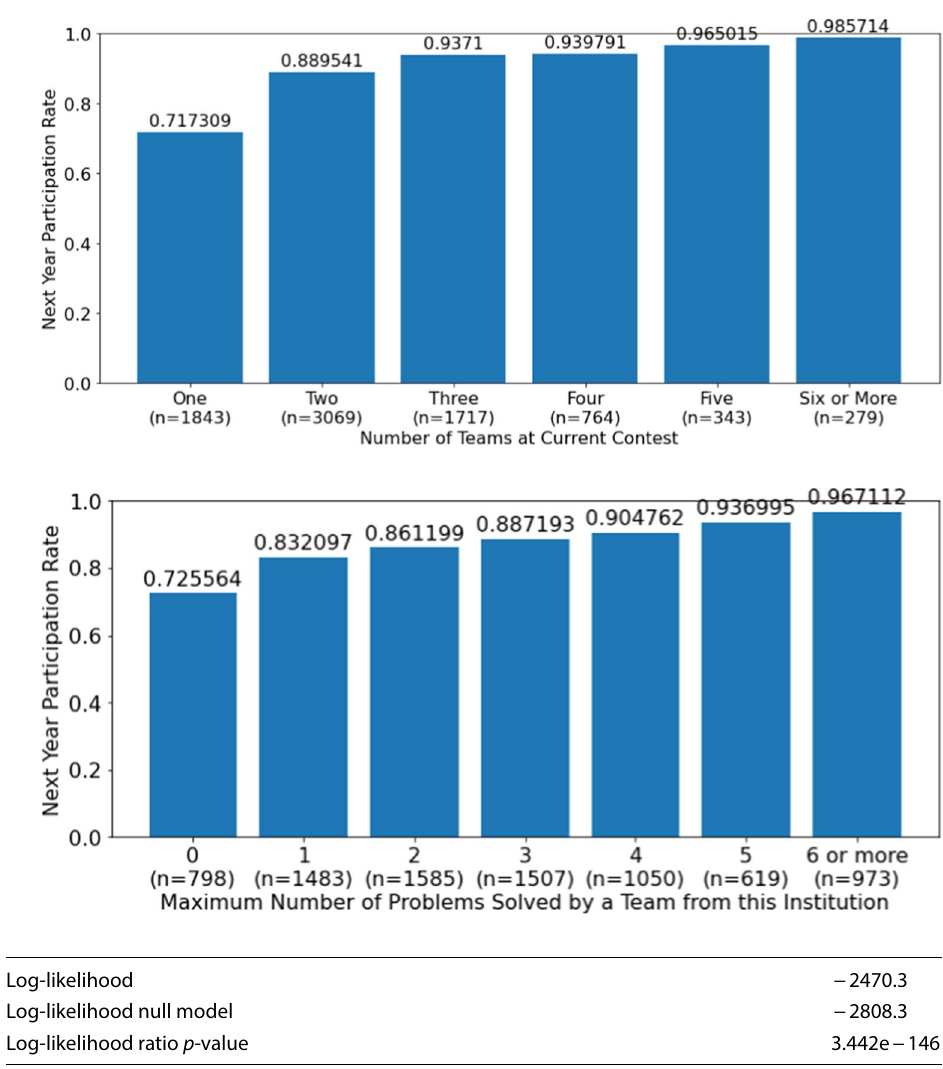
Fig. 3 Return rate as a func- tion of the number of teams